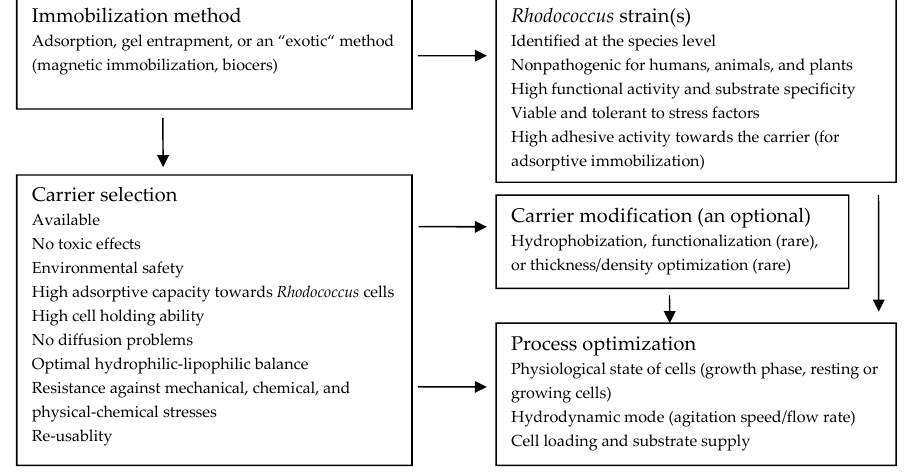
Figure 1. A general scheme to obtain stable biocatalysts based on immobilized Rhodococcus cells.